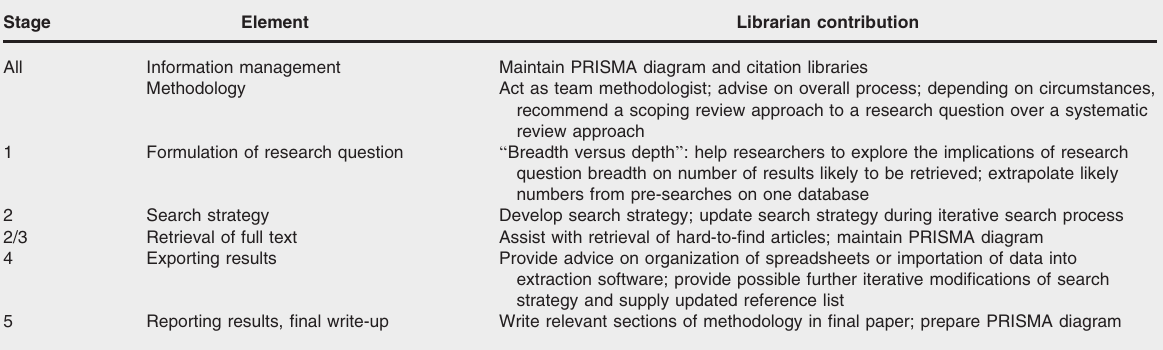
Recommended librarian contributions to scoping